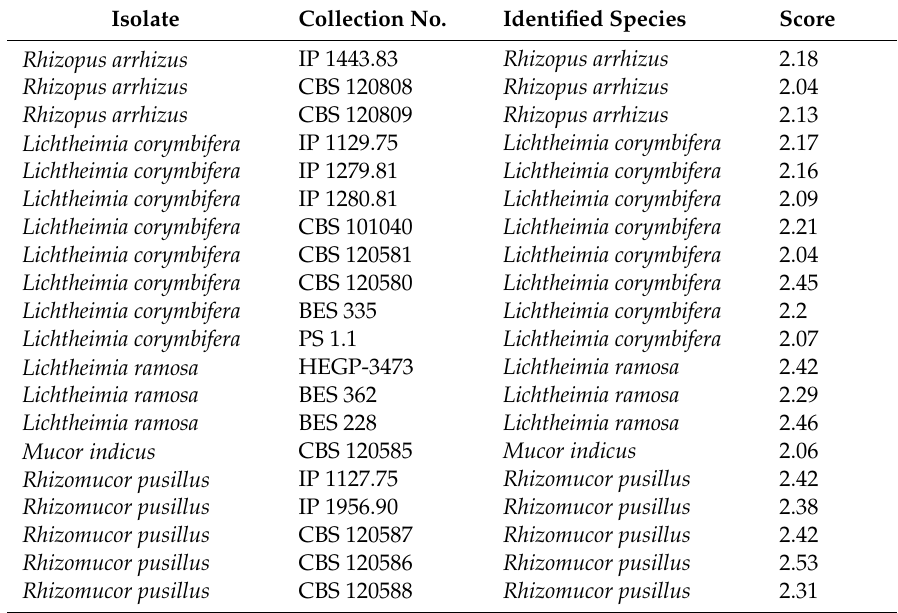
Table 2. Identification and corresponding log-score value for 20 Mucorales isolates used for the accuracy test of the